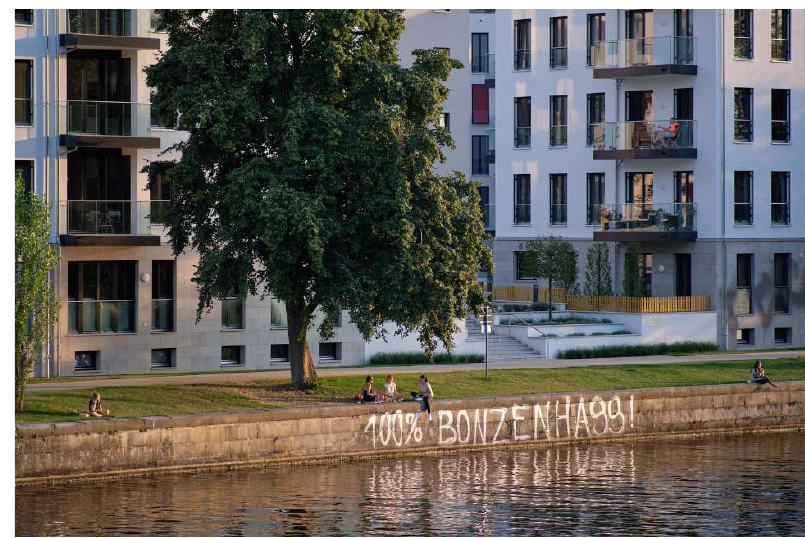
Figure 3. River side luxury condos, and a message of hate directed at the rich. Berlin 2020.